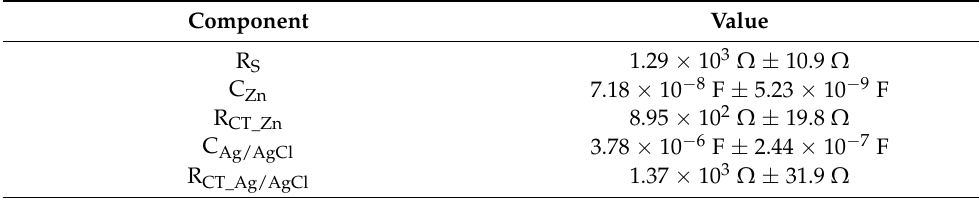
Table 1. Equivalent Circuit Values for a Single Cell Battery.